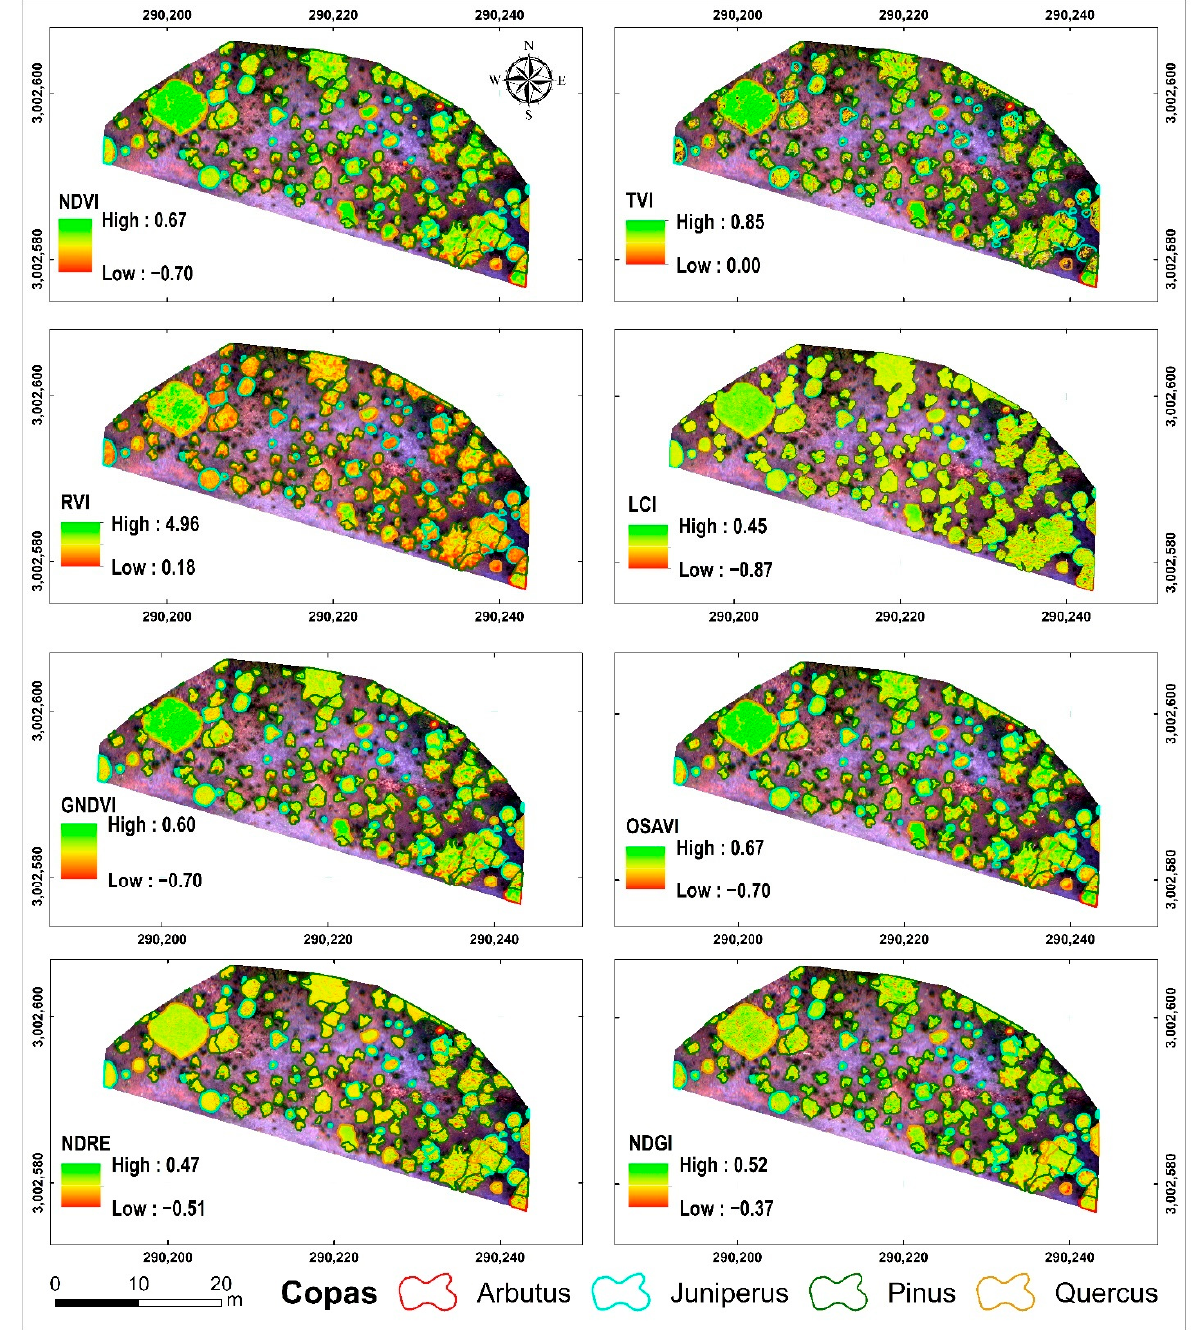
Figure 7. Vegetation indices of “El Cordoncito” in Mesa del Pawiranachi, NDVI = normalized difference vegetation index, GNDVI = green NDVI, LCI = leaf chlorophyll index, NDRE = normalized difference red edge index, OSAVI = optimized soil adjusted vegetation index, RVI = ratio vegetation index, TVI = transformed vegetation index, NDGI = normalized difference greenness index.